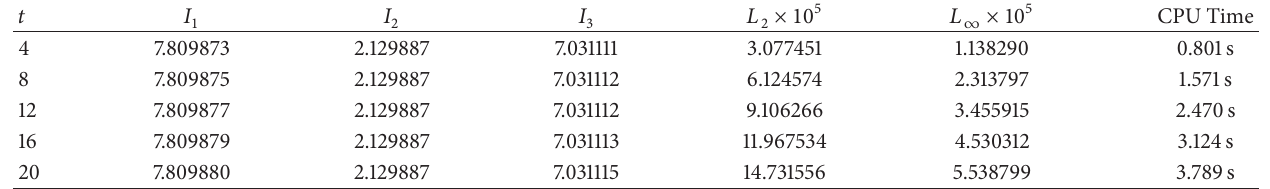
Table 5: Invariants and error norms for single solitary wave with 𝑐 = 0.18 , ℎ = 0.1 , 𝑘 = 0.1 , −80 ≤ 𝑥 ≤ 120